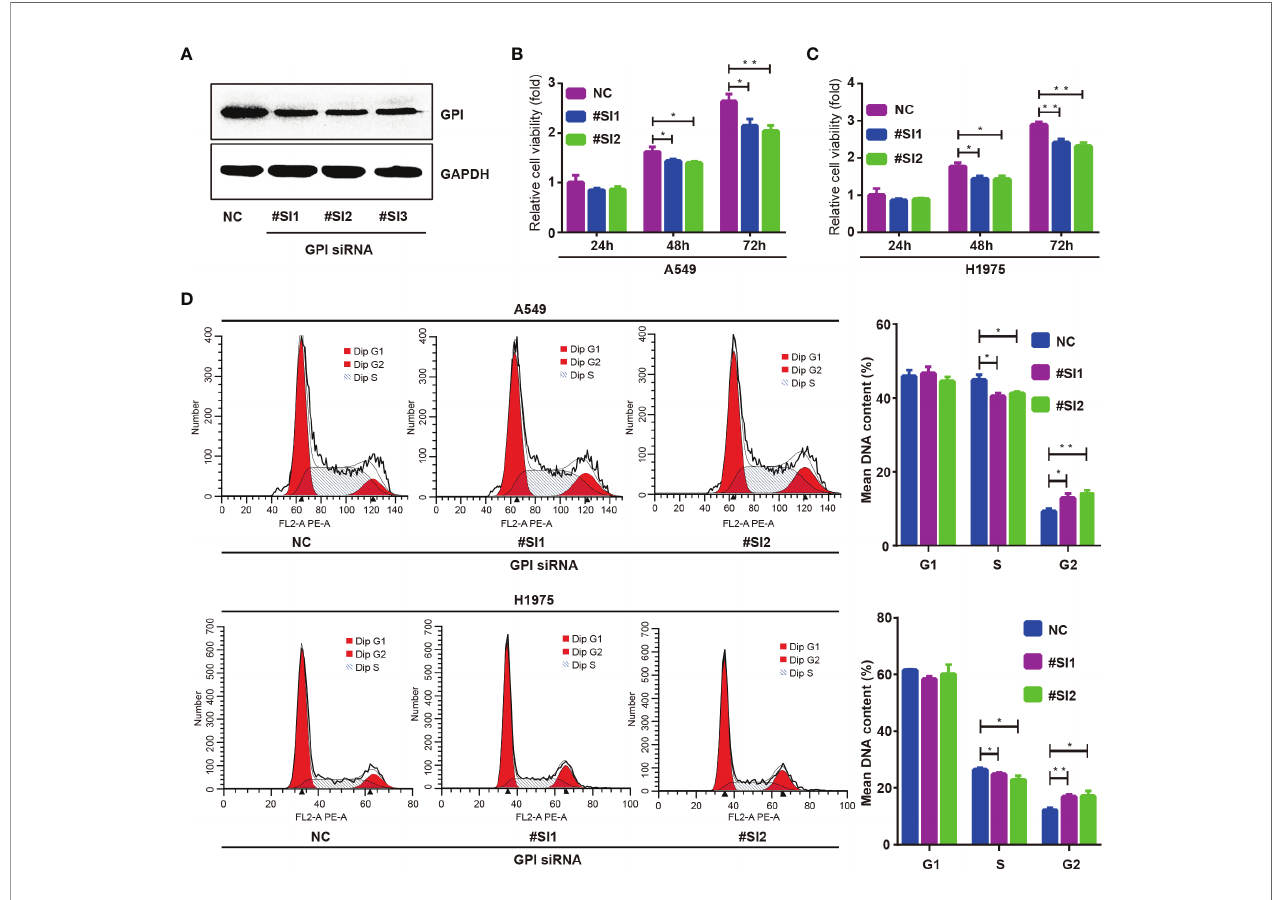
FIGURE 9 | Glucose-6-phosphate isomerase (GPI) regulates the cycle progression of lung adenocarcinoma (LUAD) cells. (A) Western blot detection of the interfering ability of GPI siRNA in A549 cells. A549 and H1975 cells were transfected with GPI siRNA #SI1 and #SI2. (B – D) CCK-8 was used to detect the proliferation ability of A549 cells (B) and H1975 cells (C) , and fl ow cytometry was used to detect the cell cycle distribution of A549 and H1975 cells (D) . *p < 0.05, **p <